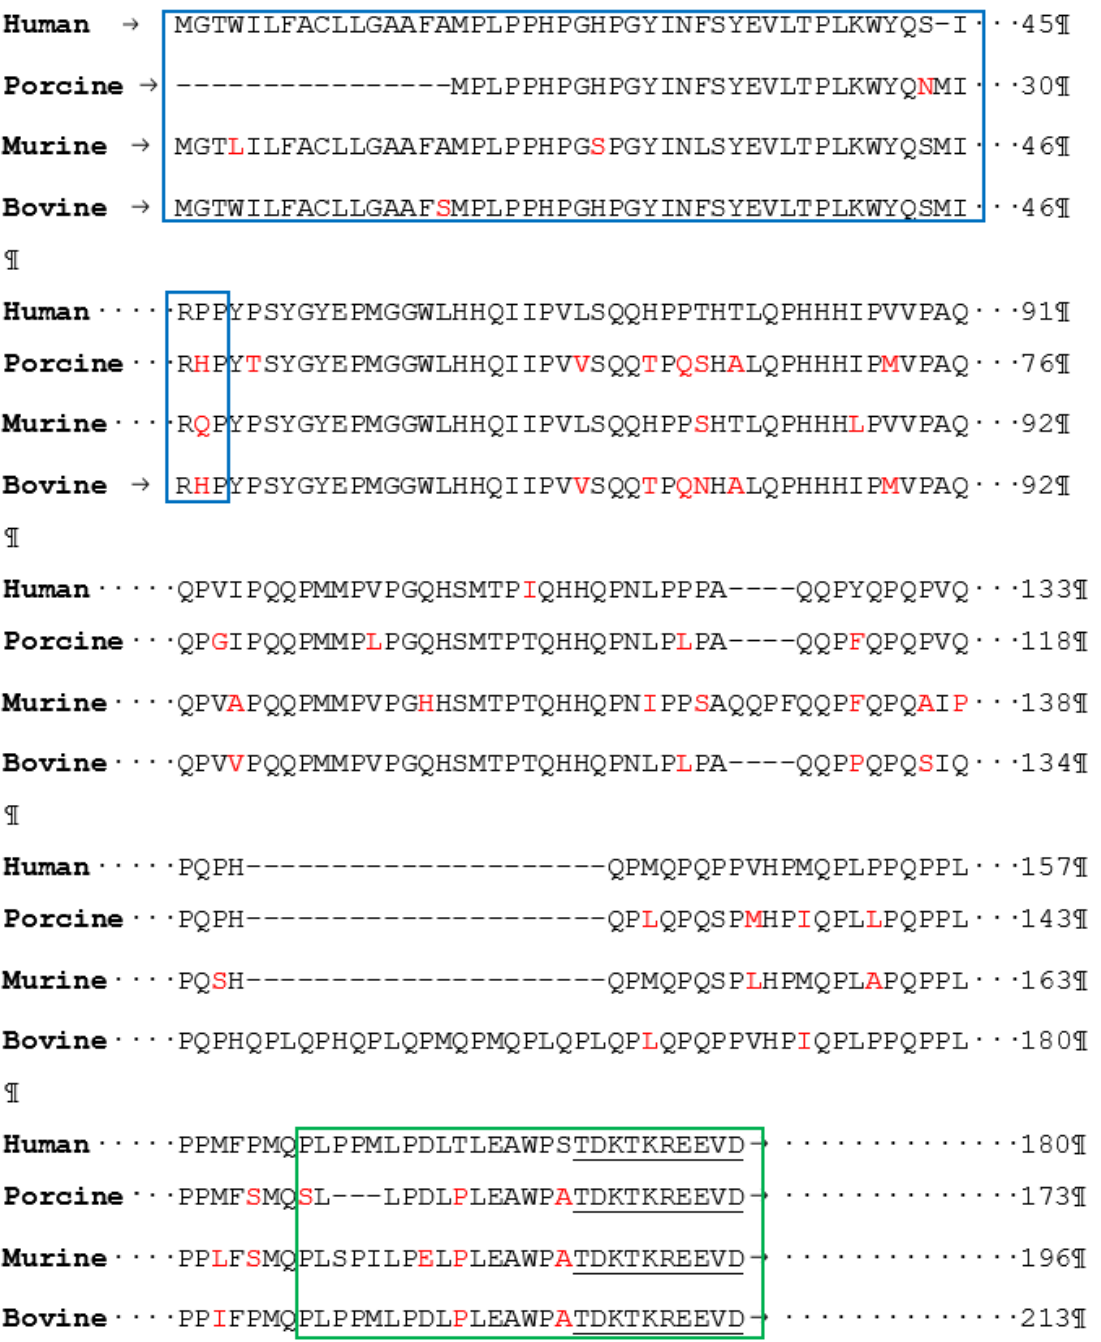
Figure 2. Alignment of native amelogenin protein from different species. The blue boxed areas indicate the N-terminal domain, the green boxed area indicates the C-terminal domain, underlined residues indicate the highly charged C-terminal tail, and red indicates the amino acid residues, which are non-homologous in comparison to the native human amelogenin protein. The (-) dash indicates the alignment gap.